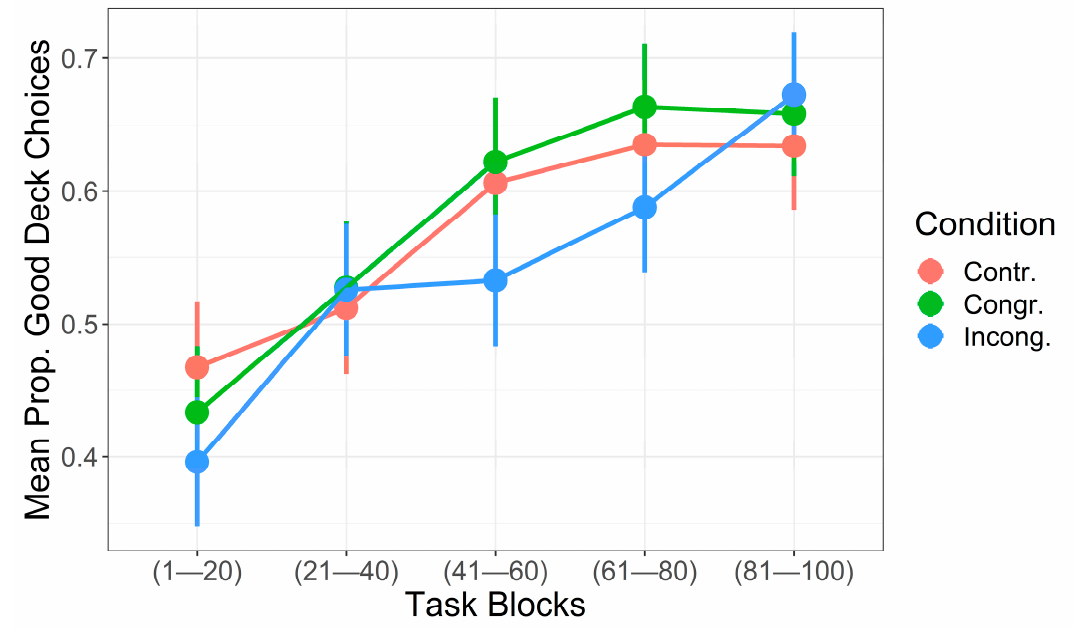
Figure 1. Descriptive statistics for the proportion of selections from Good decks across trails in the three experimental conditions. Error bars represent Standard Error.